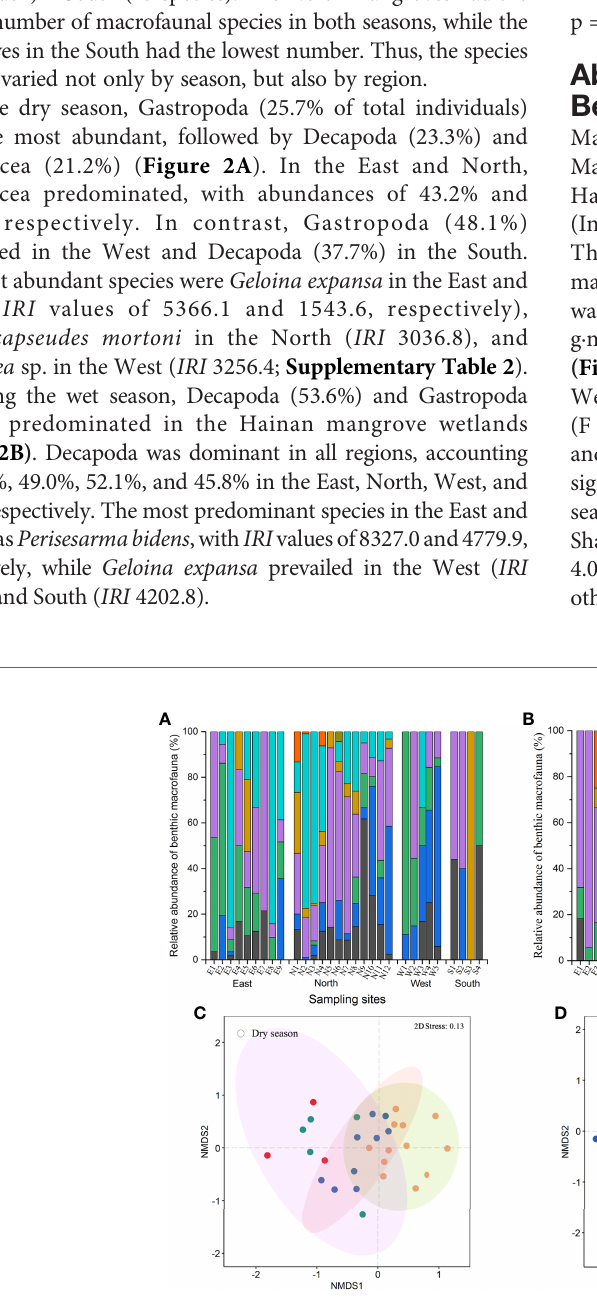
FIGURE 2 | Benthic macrofauna in the mangrove wetlands on Hainan Island in different seasons. Community structure during the (A) dry and (B) wet seasons and non-metric multidimensional scaling (NMDS) maps during the (C) dry and (D) wet